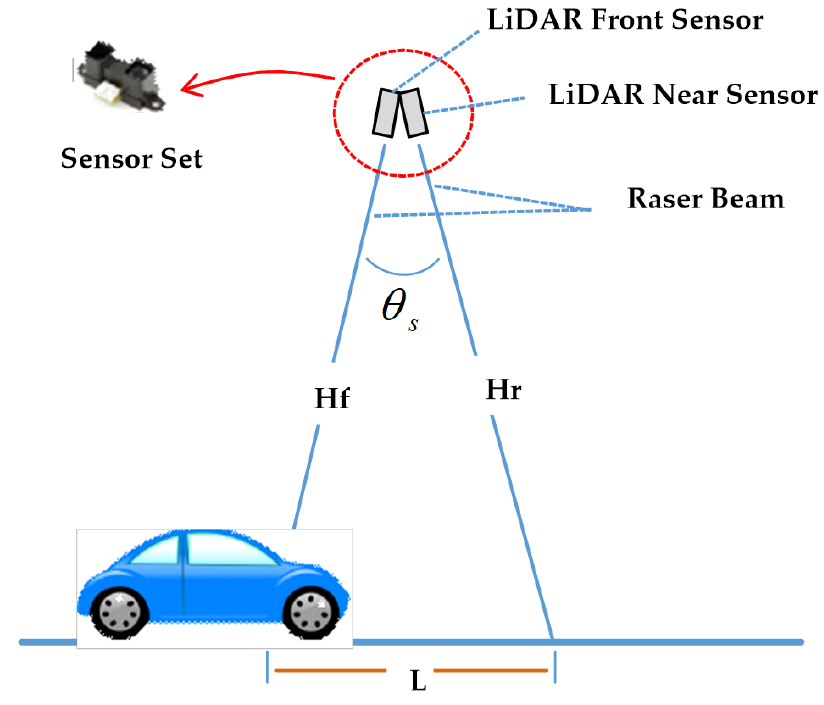
Figure 7. Vehicle detection on lane.